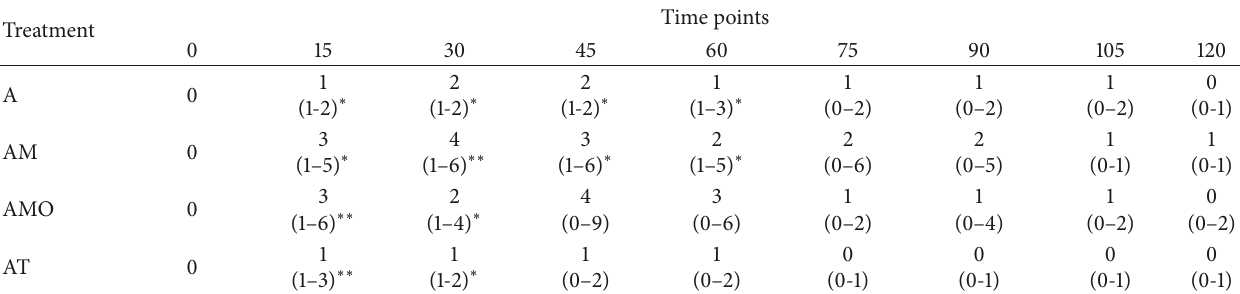
Table 3: Median (minimum–maximum) of sedation scores in six ewes following intravenous injection of acepromazine alone (A), acepromazine-methadone (AM), acepromazine-morphine (AMO), or acepromazine-tramadol (AT).